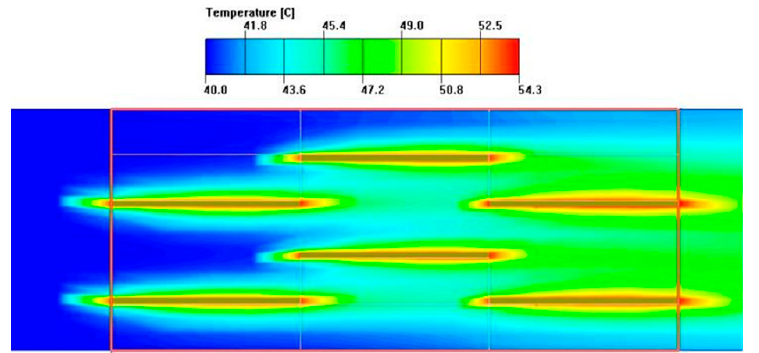
Figure 8. Temperature contour of fin.